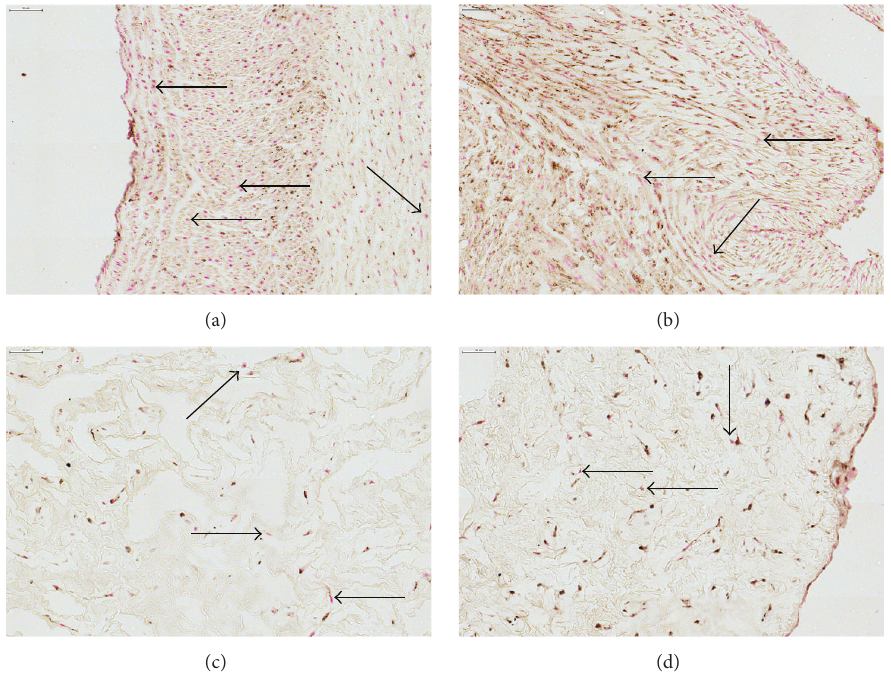
Figure 8: Staining of umbilical cord tissue for Oct4 expression (brown). Nuclei (red) were visualized using NFR counterstain. Images are shown for umbilical cord areas: (a) vein, (b) arteries, (c) Wharton’s jelly, and (d) cord edge and amniotic epithelium. Scale bars = 50 𝜇 m. Unstained cells (black arrows) are found in all anatomical compartments of the cord. Representative images of 3 different experiments are shown. Images of control staining without primary antibody are available in the electronic Supplementary Material, Figure S1. Scale bars = 50 𝜇 m (top left